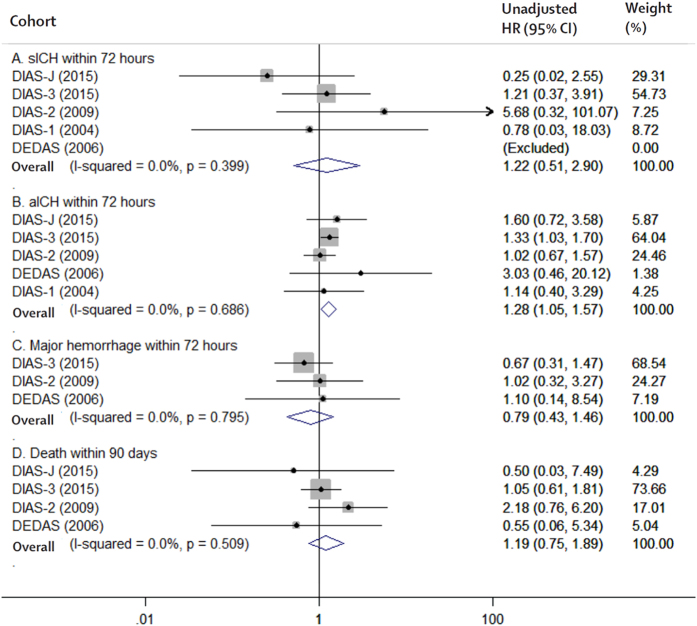
The pooled relative risk of the safety outcomes.The diamond indicates the estimated relative risk (95% confidence interval) for all patients.